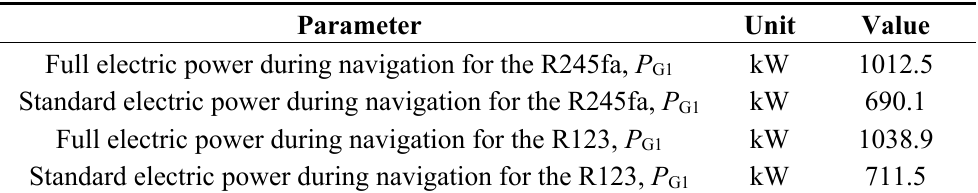
Table 4. Calculated ship electrical power using ORC.